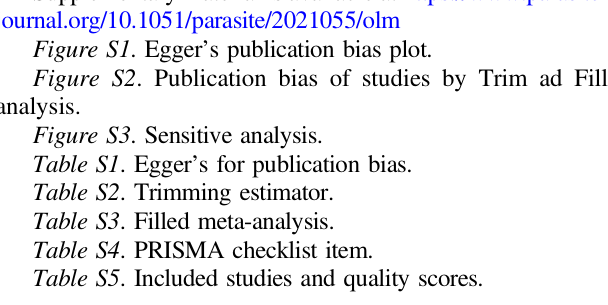
Figure S1 . Egger ’ s publication bias plot. Figure S2 . Publication bias of studies by Trim ad Fill analysis. Figure S3 . Sensitive analysis. Table S1 . Egger ’ s for publication bias. Table S2 . Trimming estimator. Table S3 . Filled meta-analysis. Table S4 . PRISMA checklist item. Table S5 . Included studies and quality